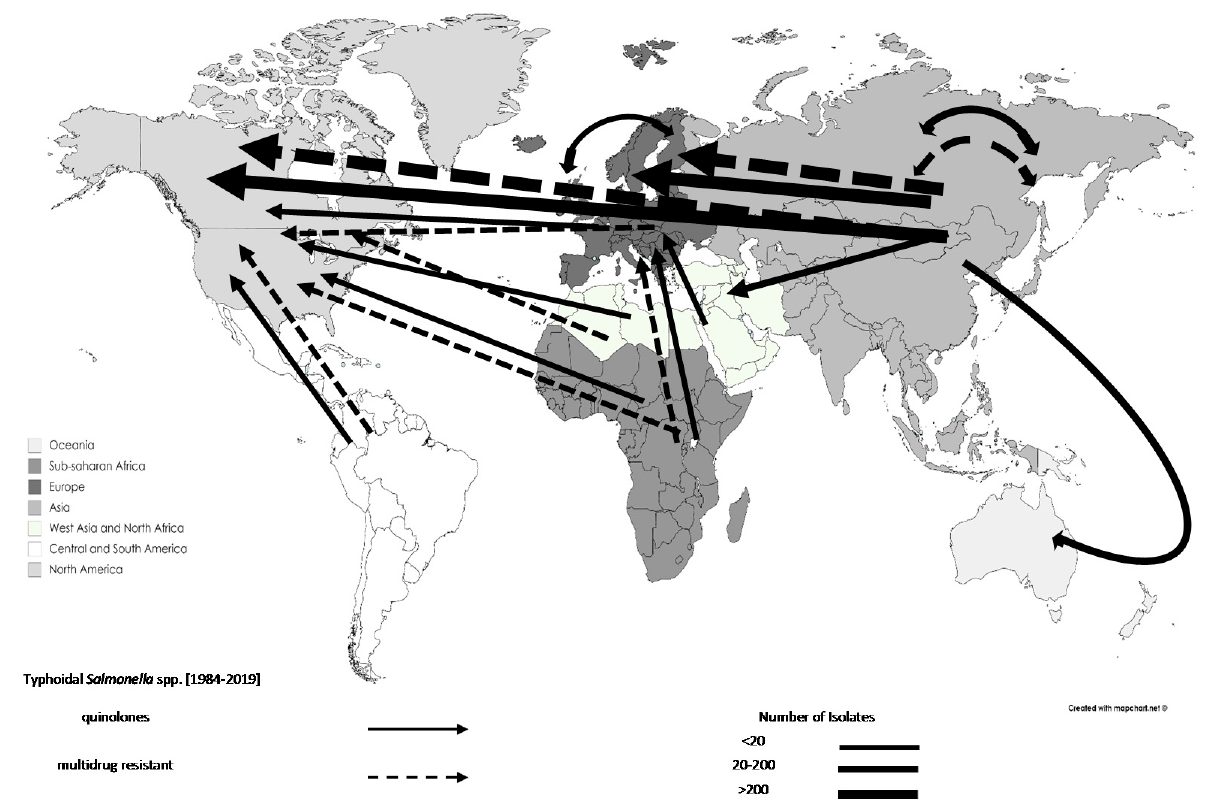
Figure 3. Travel-related antimicrobial resistant typhoidal Salmonella spp. movements, 1984–2019: data are shown by arrows representing antimicrobial resistant isolate movements, where the arrowhead represents the destination and the base of the arrow represents the source. Thus, double-headed arrows represent movements between the same regions. Different regions are represented by different shades.